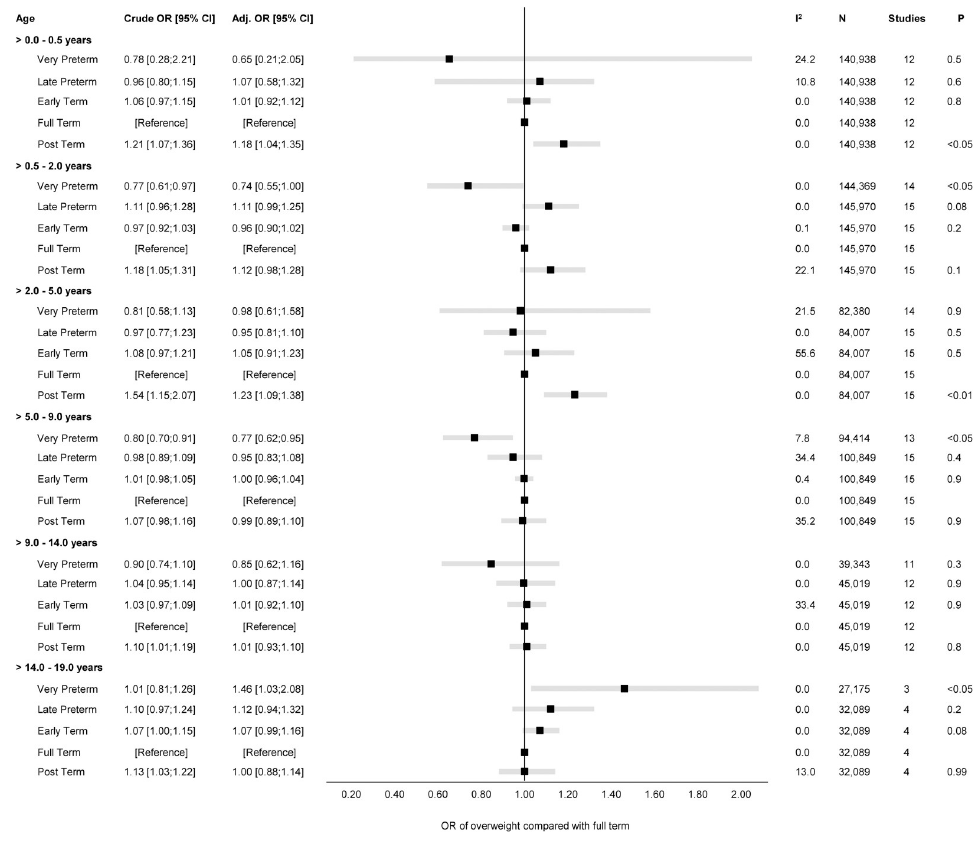
Fig 4. Forest plot of associations between GA (clinical categories) and odds of overweight. Overall unadjusted and adjusted ORs with 95% CIs from IPD meta-analyses of the study-specific logistic regression model estimates, where cohorts were assigned weights under the random-effects model. The dot in the forest plot represents the adjusted OR, while the whiskers span the 95% CI, whereas I 2 -statistics (I 2 ), sample size (N), studies, and p -value (two-sided, < 0.05) relate to adjusted OR. Estimates reflect OR for overweight compared to full term (reference category) in early infancy ( > 0–0.5 years), late infancy ( > 0.5–2.0 years), early childhood ( > 2–5 years), mid-childhood ( > 5–9 years), late childhood ( > 9–14 years), and adolescence ( > 14–19 years). Models are adjusted for sex of child, and the following maternal characteristics: age at child’s birth, education, height, prepregnancy BMI, smoking during pregnancy, parity, ethnic background, gestational diabetes and hypertension, and preeclampsia. Cohort-specific estimates were adjusted for the maximum available set of the confounding variables (see Table 1). BMI, body mass index; CI, confidence interval; GA, gestational age; IPD, individual participant data; OR, odds